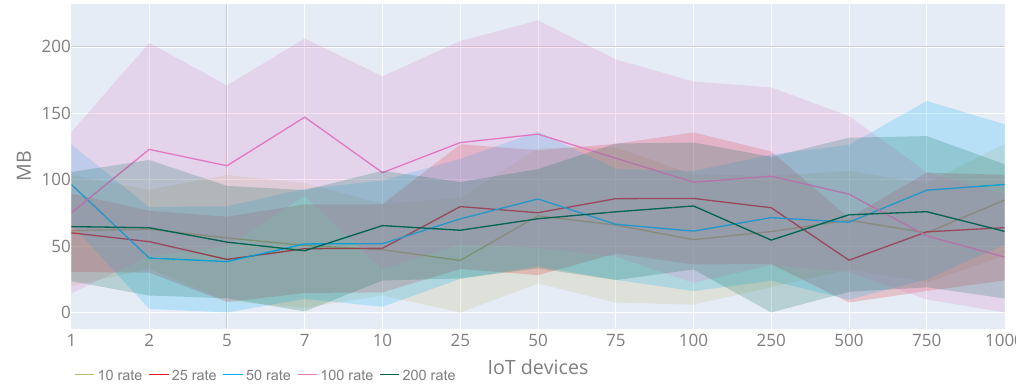
Figure 18. Memory usage of the observations injection with a rate of requests 10, 25, 50, 100 and 200 requests per second.